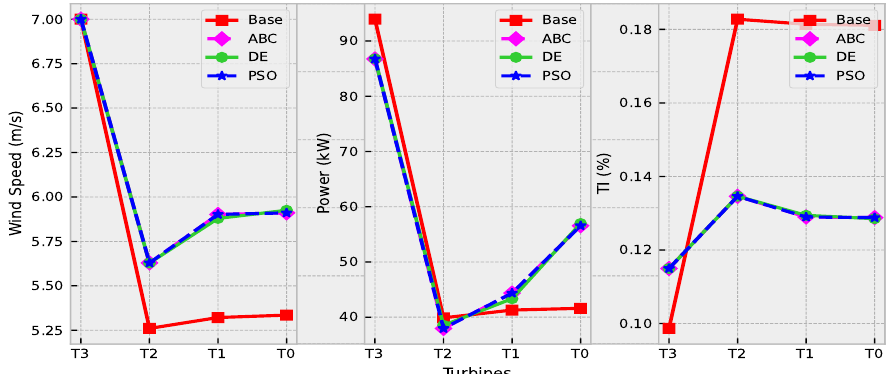
Figure 10. 7 D deployment distance at 7 m/s mean wind